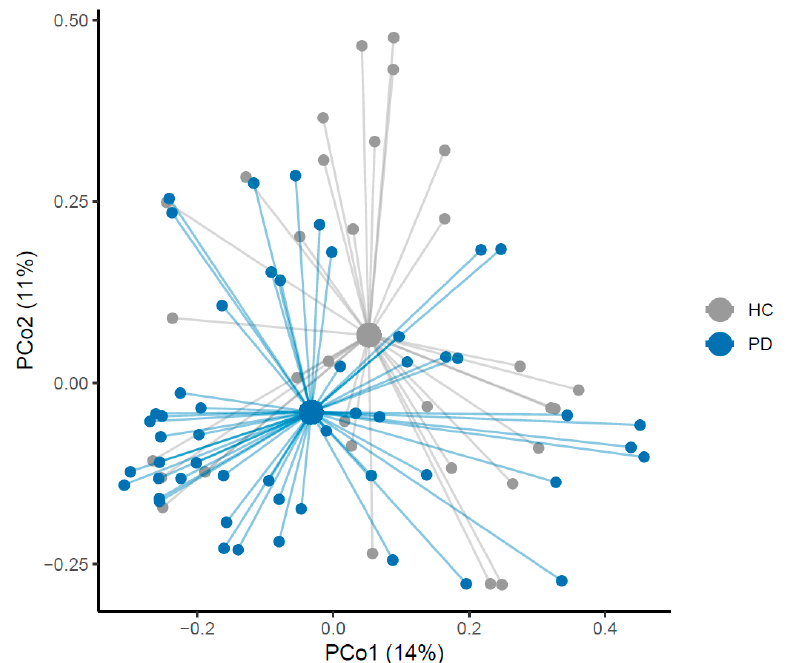
Figure 2. Principal Coordinates Analysis (PCoA) of unweighted UniFrac. HC: Healthy Controls; PD: Parkinson Disease.